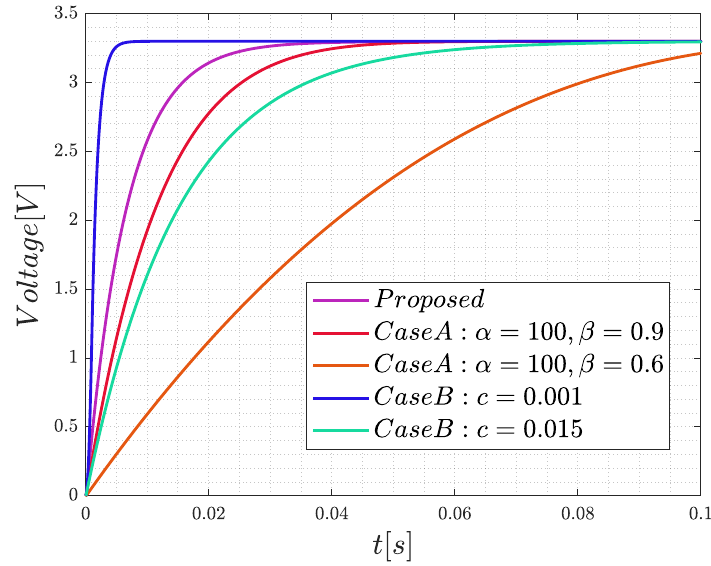
Figure 4. Voltage responses of the SMC for the three sliding surfaces described in Section 2.